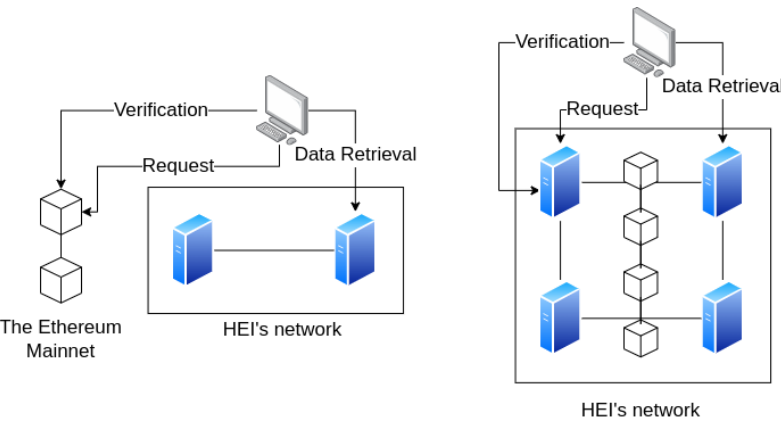
Figure 7. The connections in permissioned and permissionless systems.